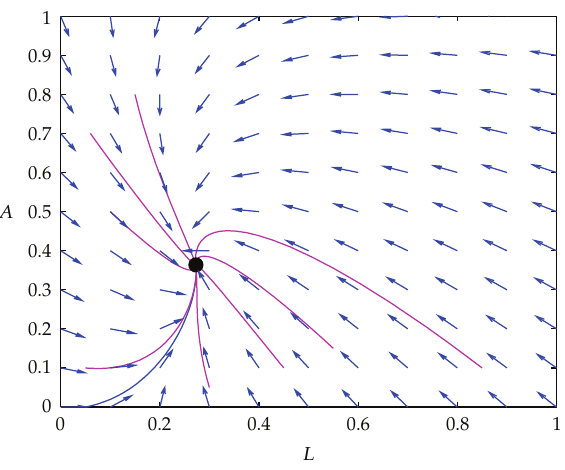
Figure 4: Phase portrait for the system given in Example